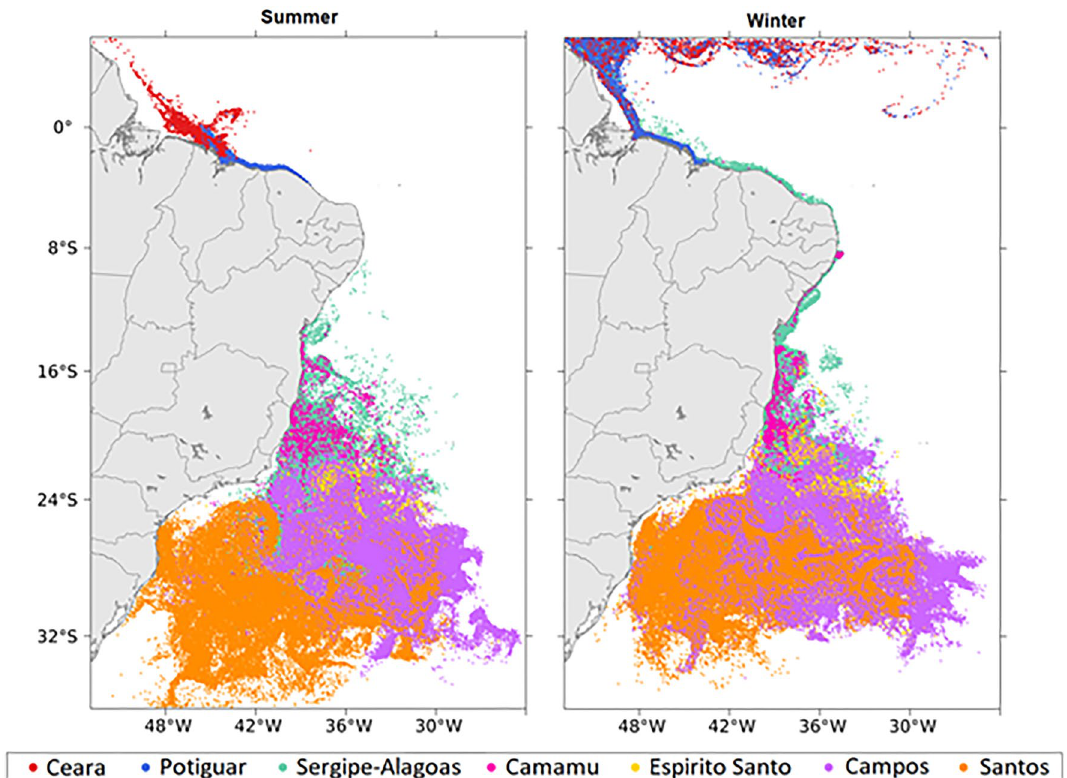
Figure 3. Six-year superposed final position of the surviving larvae after 90 days of simulation during the austral summer (left) and winter (right), in which each color represents the source basins. Created with Matlab R2018a (http:// www. mathw orks. com).